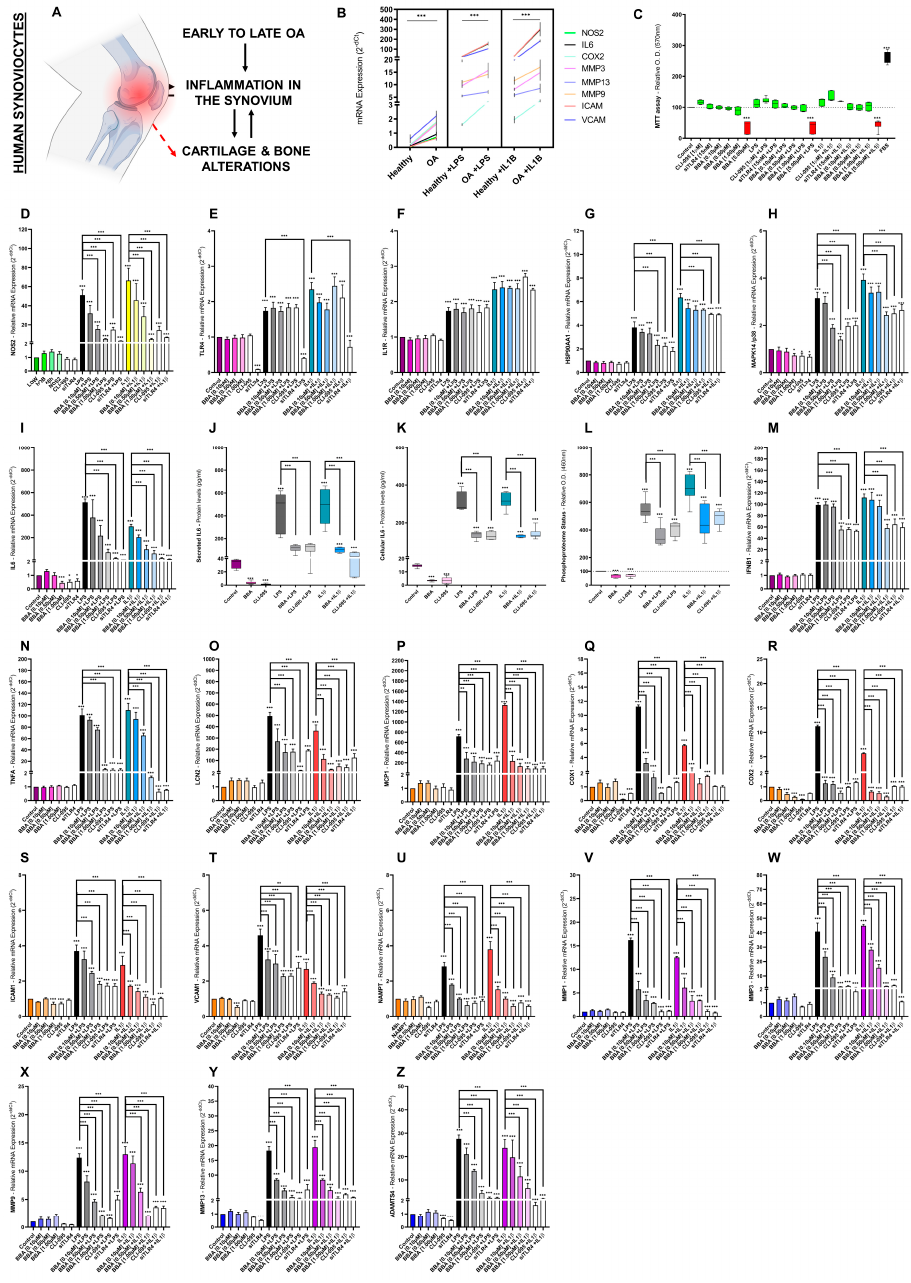
Figure 5. BBA effects on TLR4/IL1R-mediated innate immune response in human synoviocytes: ( A ) Diagram of the interconnection between articular tissues in osteoarthritis; ( B – Z ) primary human healthy ( B ), OA ( B ) and non-primary human SW982 ( C – Z ) synoviocytes (hSW) were treated with BBA (0.10–5 µM), CLI-095 (1 µM), or siTLR4 (15 nM) for 24 h and cotreated with LPS (100 ng/mL) or IL1 β (0.1 ng/mL) for another 48 h. Independent biological replicas ( n = 6) were normalized (control), expressed as the mean ± SEM and represented by the statistical significance NEJM system as *** ( p -value < 0.001), ** ( p -value < 0.002), * ( p -value < 0.033); ( C ) MTT cell viability assay in hSW syn- oviocytes displaying cell inviable doses (red), cell-viable doses (green) and FBS as a positive control; ( B , D – I , M – Z ) RT-qPCR gene expression (mRNA) of NOS2, TLR4, IL1R1, HSP90AA1, MAPK14/p38, LCN2, COX1, COX2, ICAM1, VCAM1, MCP1, NAMPT, MMP-1, -3, -9, -13, and ADAMTS4 in hu- man healthy ( B ), OA ( B ) and hSW synoviocytes ( D – I , M – Z ); ( J , K ) ELISA of secreted ( J ) or cellular ( K ) IL6 protein (pg/mL) in hSW synoviocytes; ( L ) Green malachite assay (Relative O.D. 460 nm) of phosphoproteome status in hSW